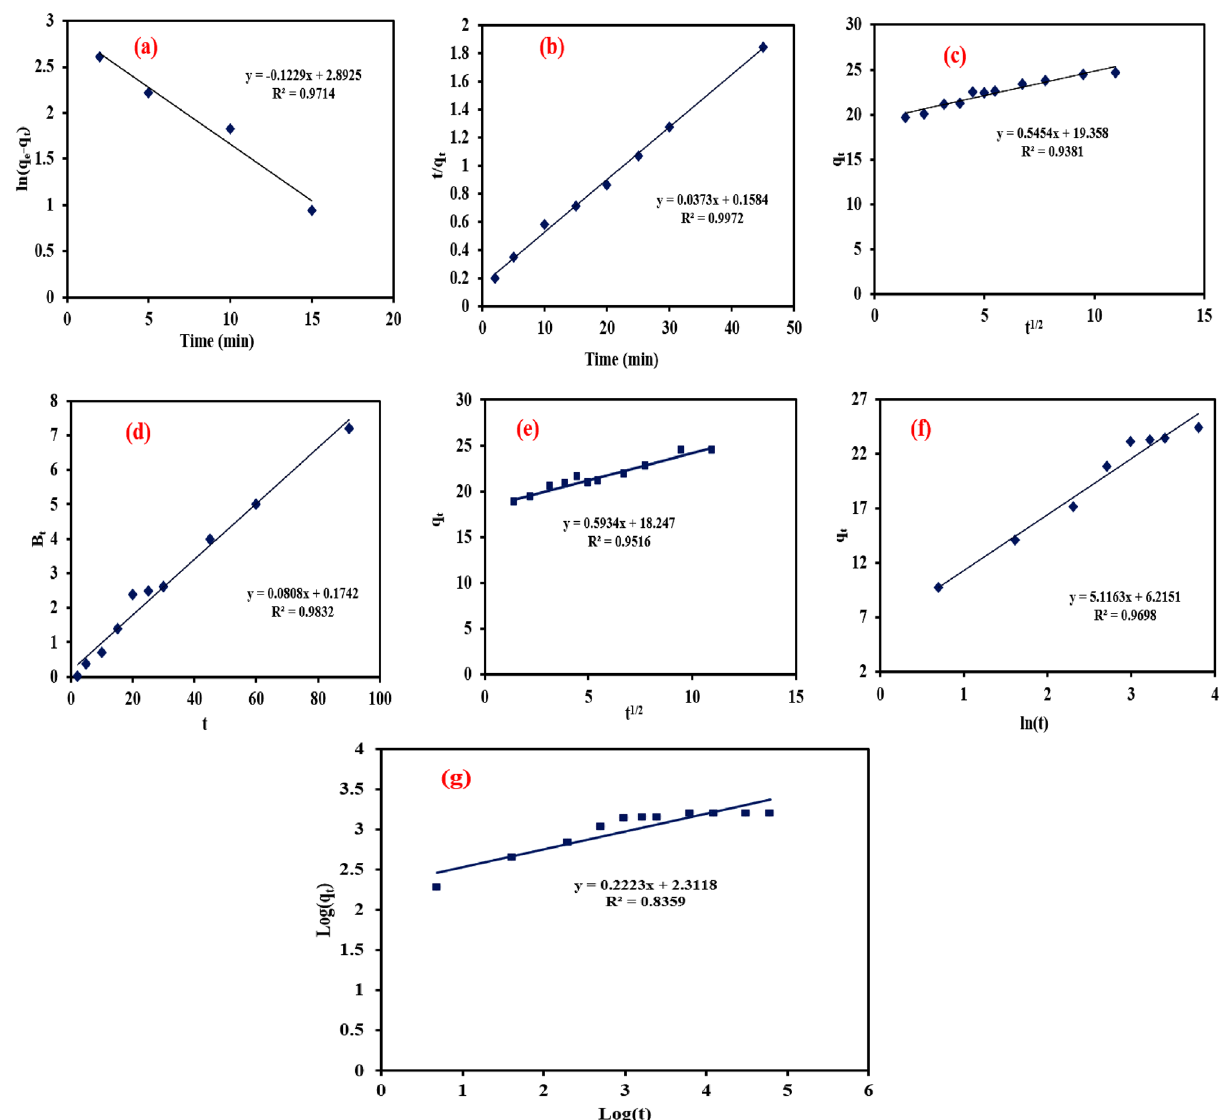
Figure 9. Adsorption kinetics of Cr(VI) ( a ) first-order model, ( b ) second-order model, ( c ) intraparticle diffusion, ( d ) Boyd model, ( e ) parabolic diffusion model, ( f ) Elovich model and ( g ) power function